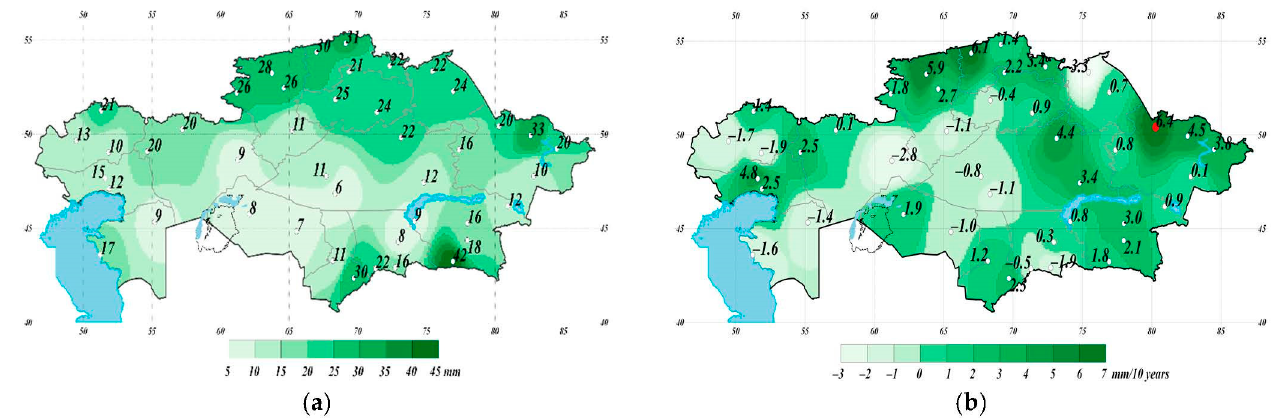
Figure 12. Spatial distribution of the index characterizing the amount of extreme precipitation (R99p) ( a ) and trends ( b ) of this parameter for the period 1971–2020. Distributions of precipitation amount to more than 10 and 20 mm per day and are characterized, respectively, by indices R10mm and R20mm (Figure 13).